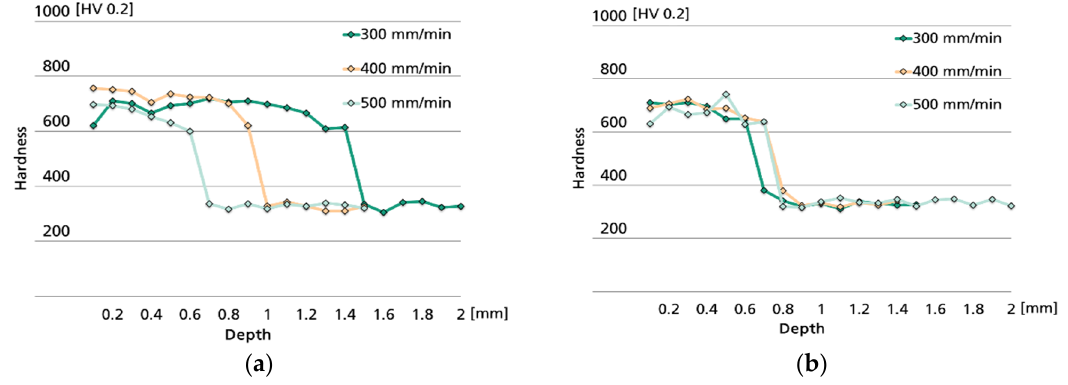
Figure 11. Hardness distribution in depth of the specimen: ( a ) of the top ‐ hat intensity profile and ( b ) the optimized intensity distribution.